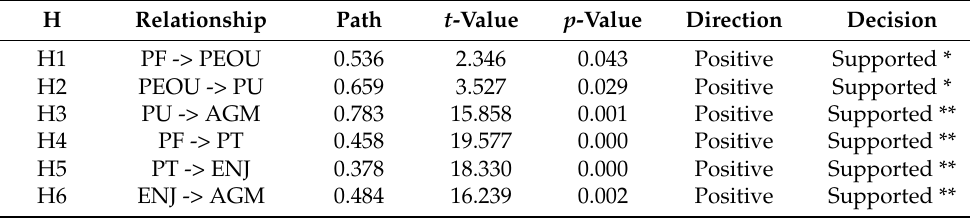
Table 10. Hypotheses-testing of the research model (significant at ** p ≤ 0.01, * p <